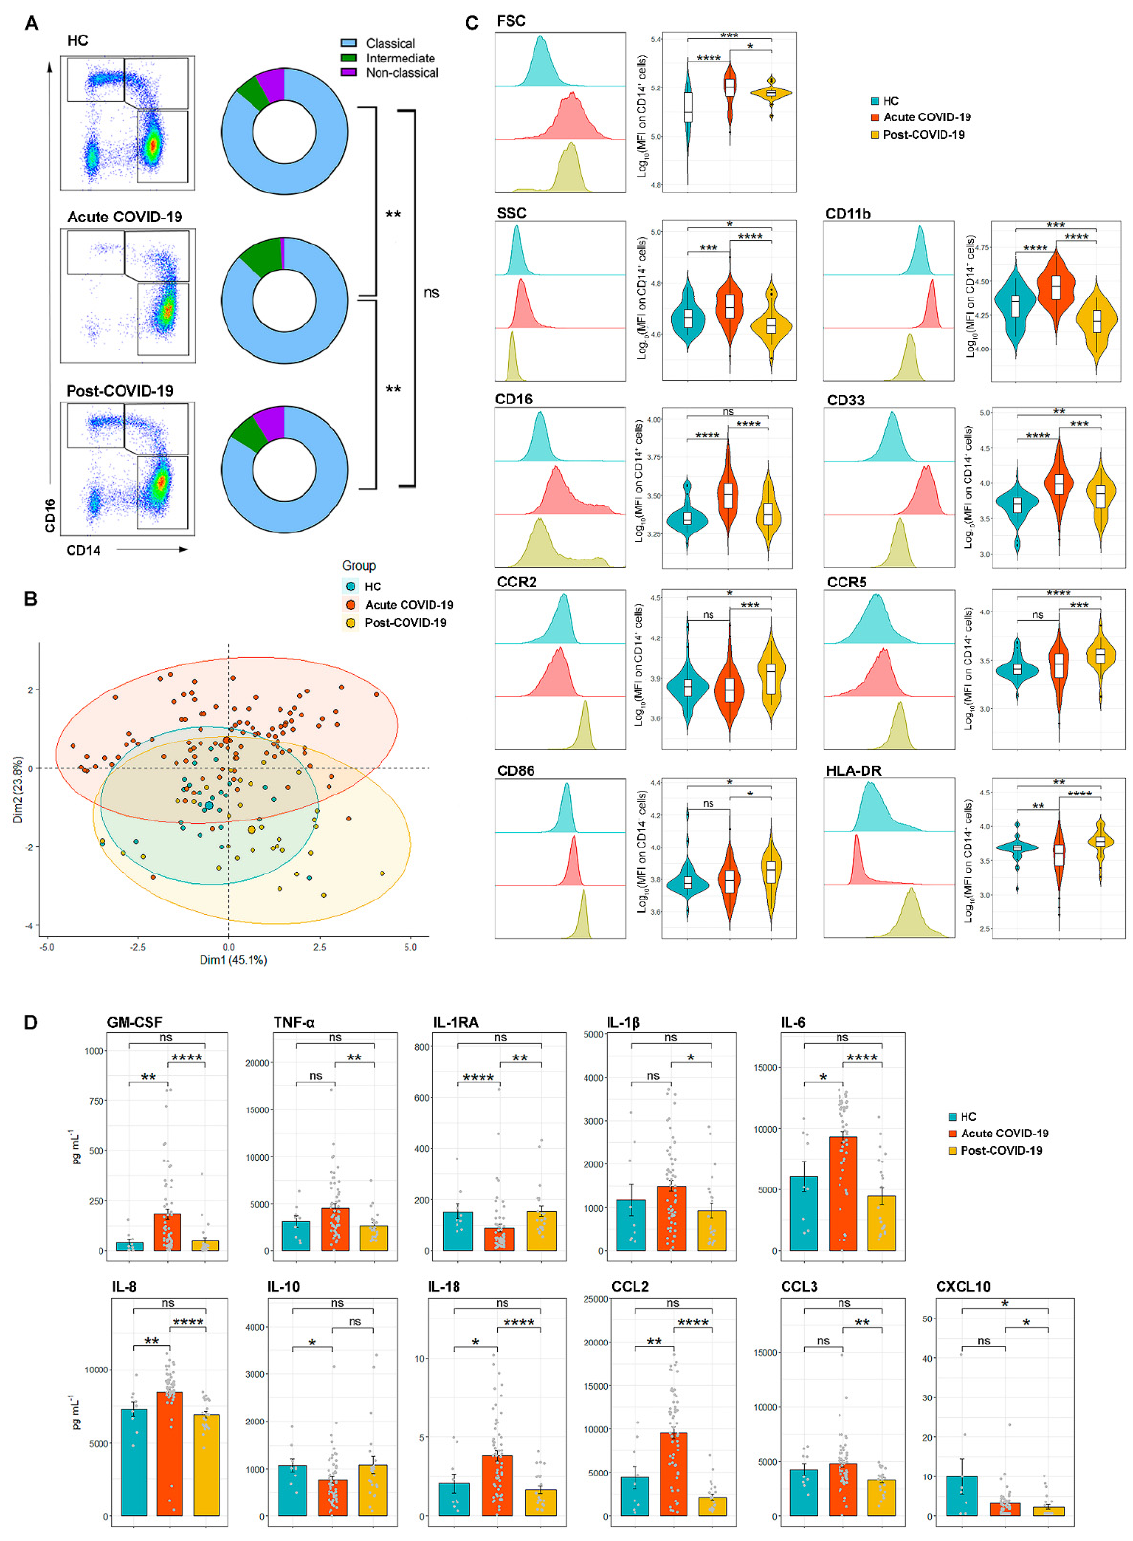
Figure 1. Circulating monocyte subsets, their surface molecule expression and their cytokine production after in vitro activation are altered in acute and post-COVID-19 patients. ( A ) Identification of classical (CD14+CD16-), intermediate (CD14+CD16+) and non-classical (CD14 − CD16+) monocytes. In HC, classical monocytes represented 77.7%, intermediate monocytes 5.7% and non-classical monocytes 6.8%. In acute COVID-19 those populations were 84.5%, 11.5% and 1.0% respectively, and in post-COVID-19 they were 75.5%, 6.9% and 7.6% respectively. ( B ) Principal component analysis (PCA)